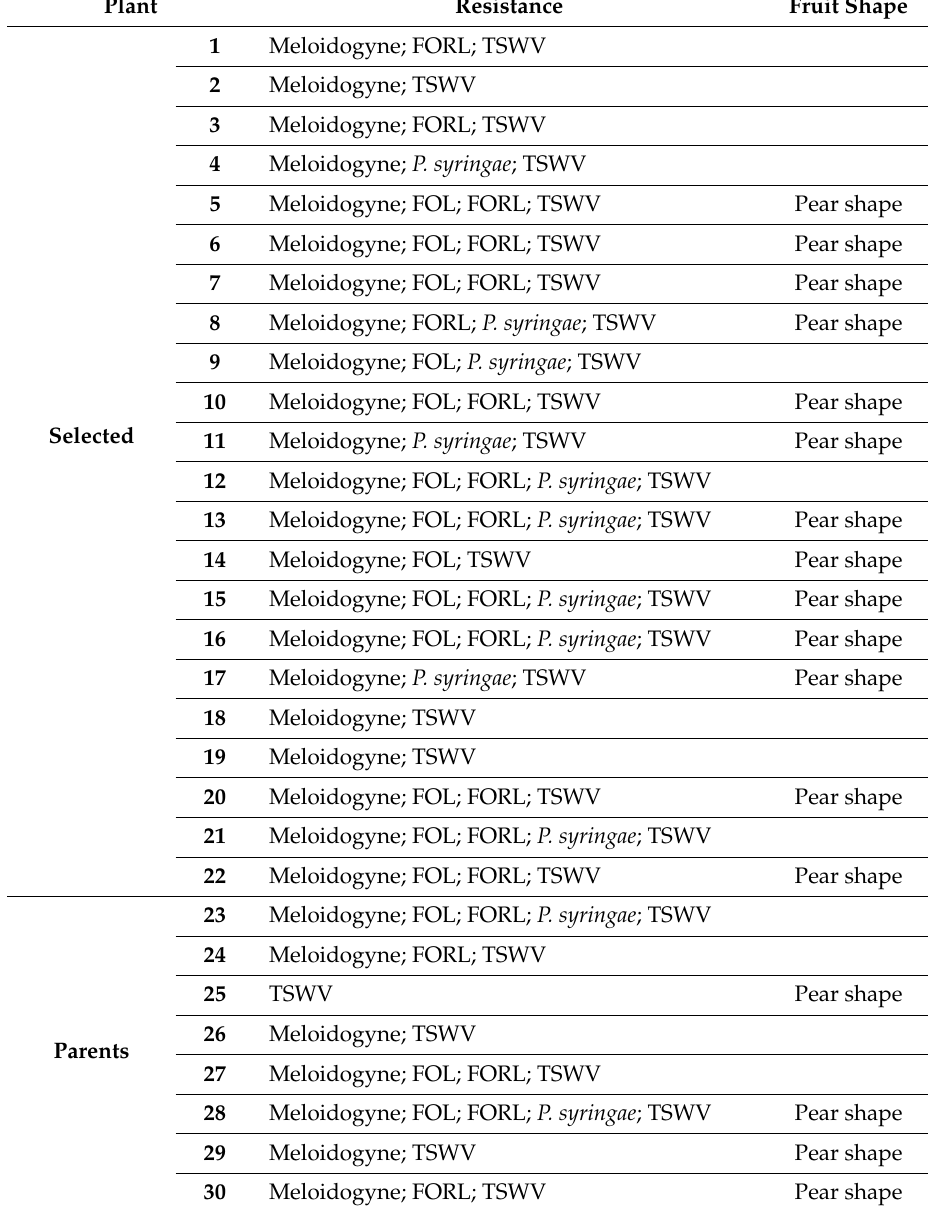
Table 4. Molecular markers of the selected and parental